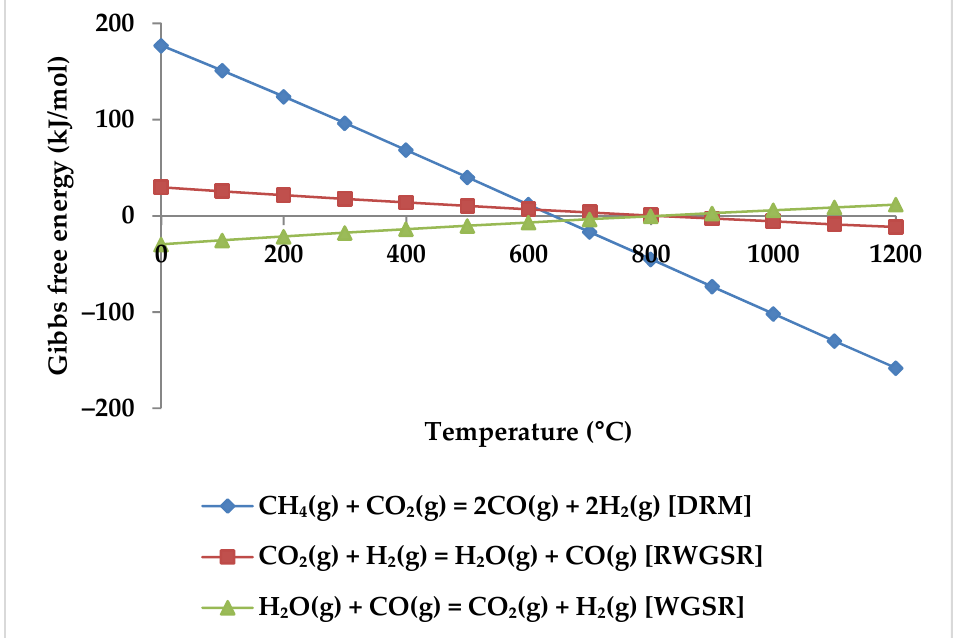
Figure 5. Gibbs free energy diagram for DRM, WGSR, and RWGSR. Lower reaction temperatures have a significant impact on the H 2 /CO molar ratios. The H 2 /CO molar ratio might drop dramatically, for instance, from 11.8 to 2.1, when the temperature rises from 400 to 600 ◦ C, regardless of the feed molar ratios. Further raising the reaction temperature to 1000 ◦ C results in a slight decrease in H 2 /CO molar Regarding the products, increasing the temperature causes a rise in the CO mole fraction from zero at 400 °C to the maximum at about 850 °C. Meanwhile, the mole fraction of CO 2 starts to decrease and reaches zero at 850 °C. This suggests that CO 2 acts in the reactions as a limiting reagent. With increasing temperature, the molar fraction of